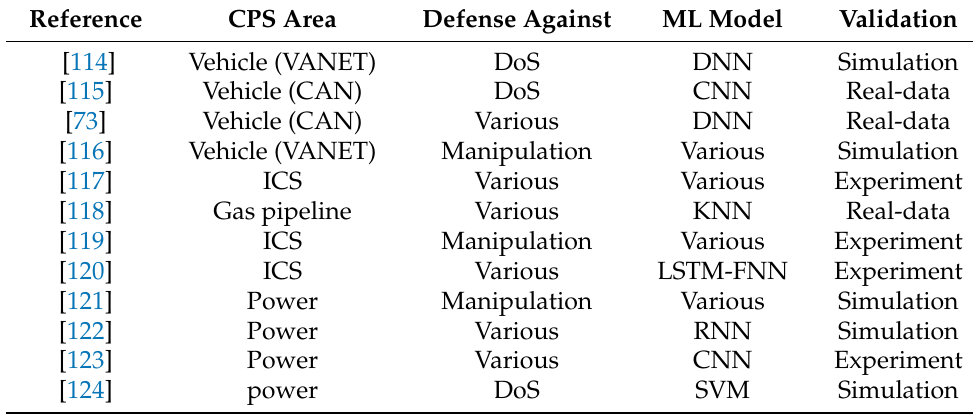
Table 2. Summary of ML-based anomaly detection methods in the network